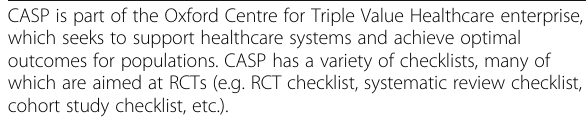
Table 5 Key concept: research appraisal tool Table 6 CASP (Critical Appraisal Skills Programme-tool)